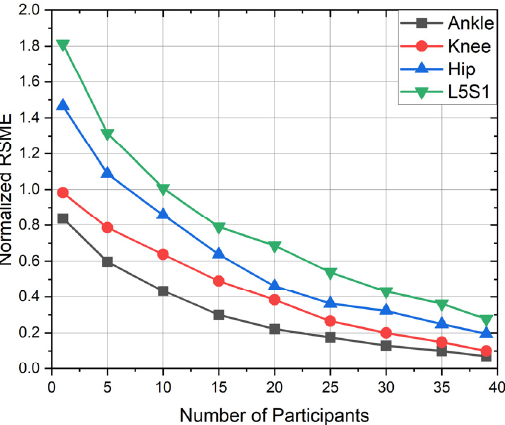
Figure 8. Model performance in terms of RSME as a function of the number of participants.